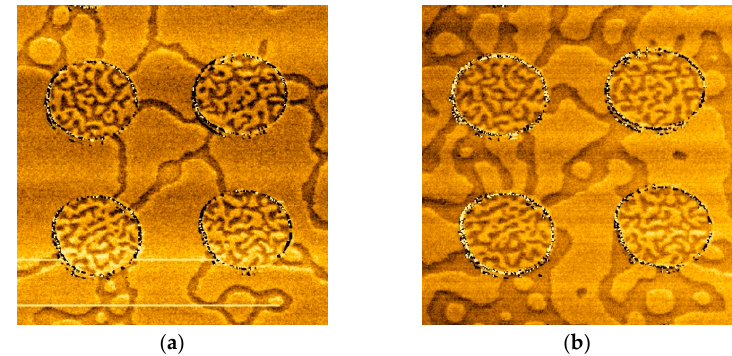
Figure 4. The MFM images of the second stage of magnetization reversal for Co/Pt sample with Co (1.5 nm) discs. ( a ) The remanent state after applying a 200 Oe reversed magnetic field; ( b ) The state after applying a 250 Oe magnetic field. The MFM frame size is 7 μ m × 7 μ m. The MFM contrast is normalized to the maximum.